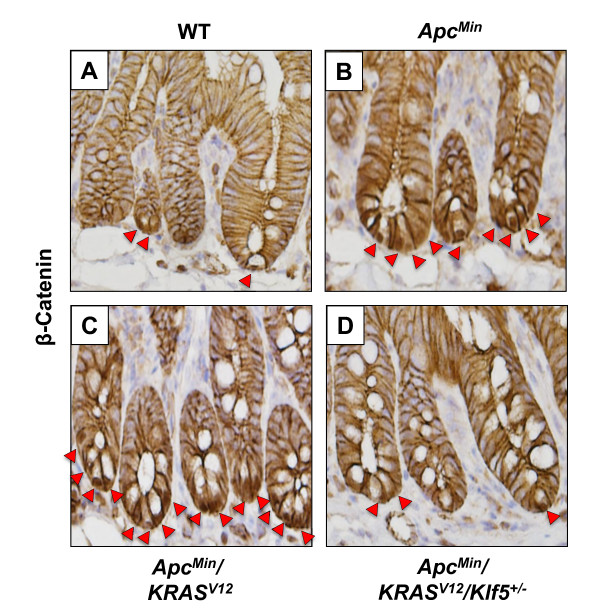
Nuclear localization of β-catenin in the normal-appearing small intestines of wild type and mutant mice. Panels are magnified immunohistochemical images of representative small intestinal crypts stained with β-catenin antibodies. Red arrowheads in all the panels indicate nuclear β-catenin staining.